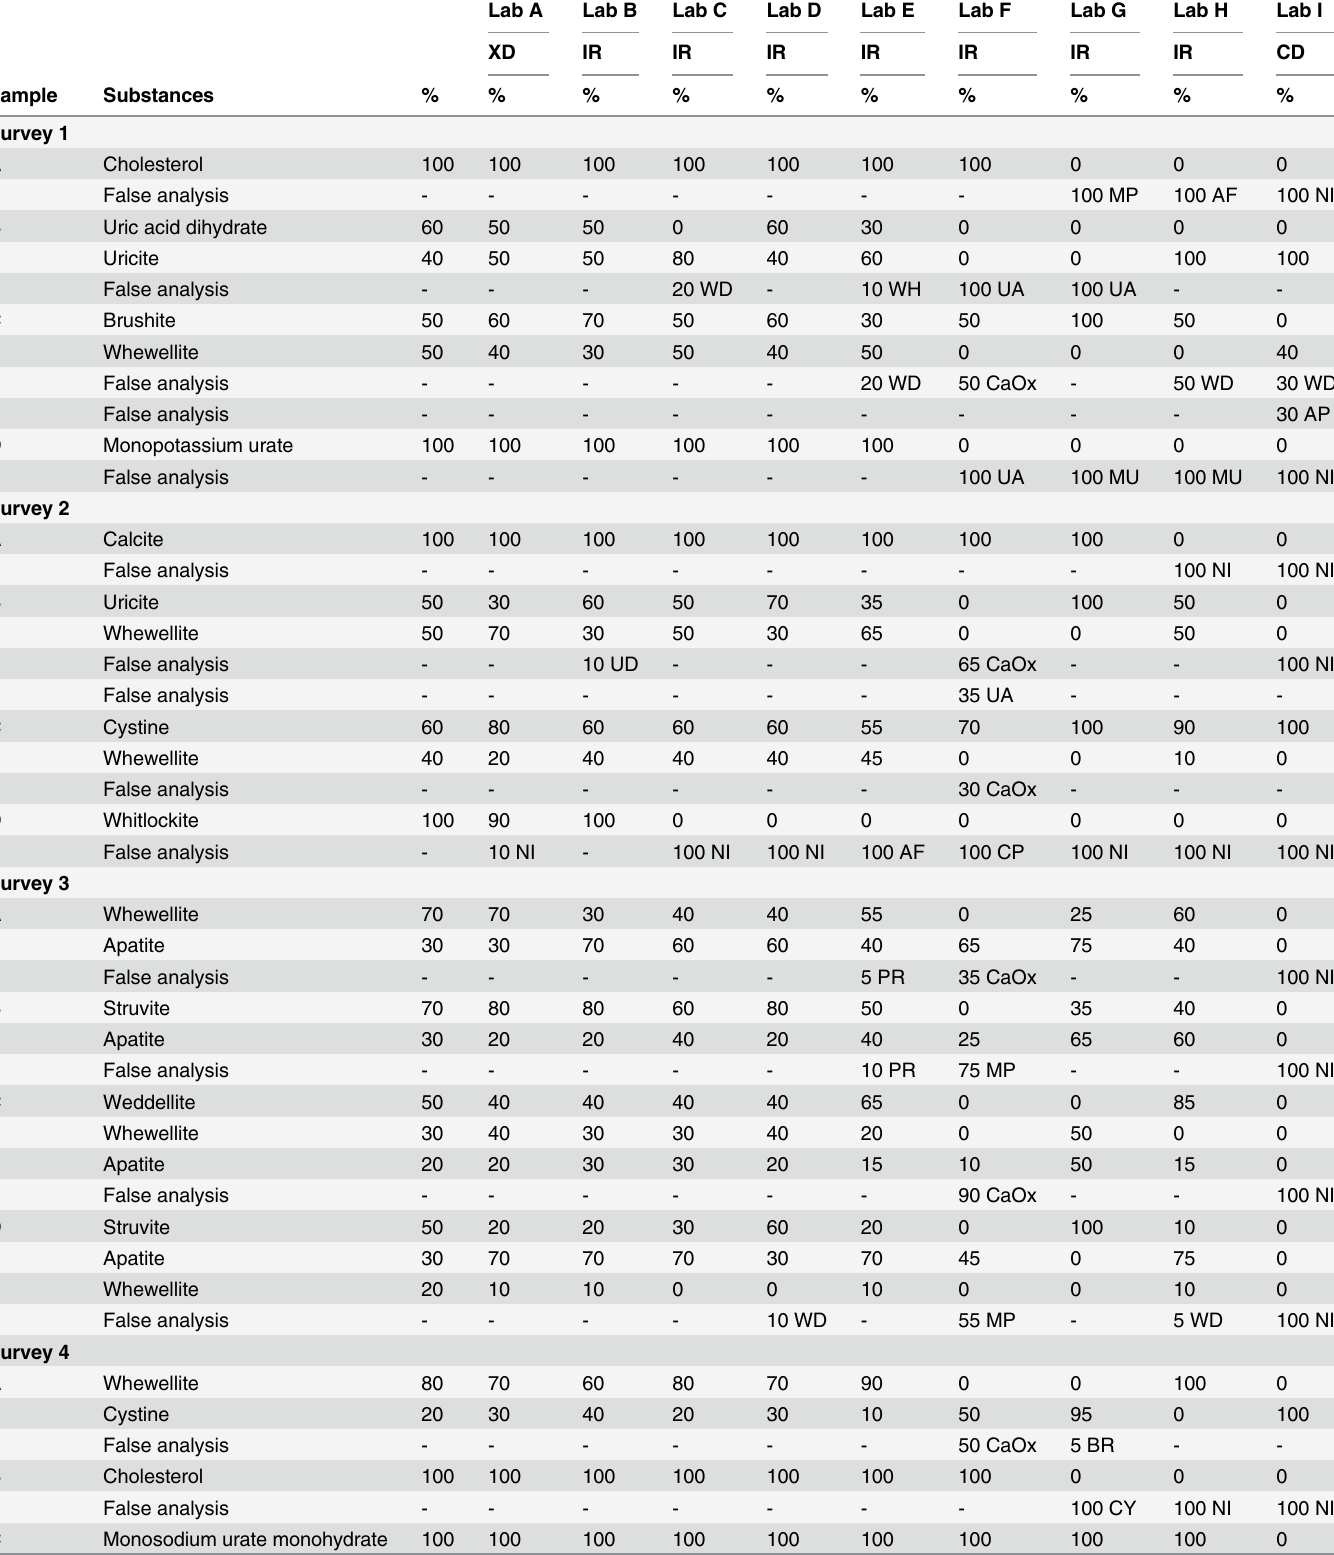
Table 2. Comparison of analytical results of nine laboratories and the correct composition of samples for stone